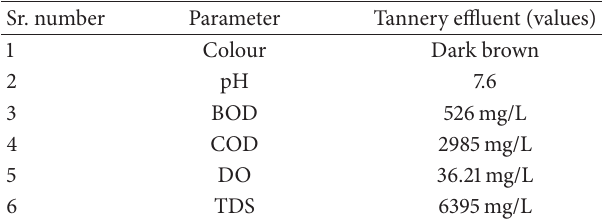
Table 3: Effect of tannery effluent on root growth in Allium cepa (all values are mean ± SD range for three observations each). The EC 50 was found to be 7.79%.